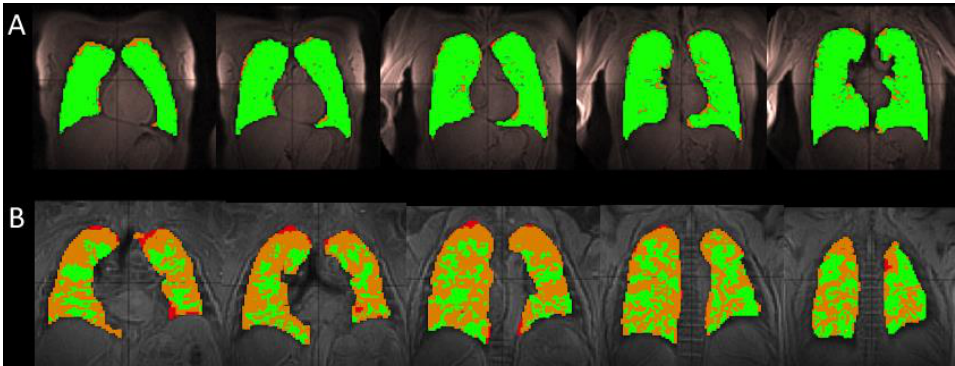
Figure 1. A comparison of the segmented ventilation images for a single healthy (H2) ( A ) and IPF (I2) subject ( B ). The healthy subject has mainly areas of normal (green) ventilation, with hypoventilation (orange) and no ventilation (red) areas located on the periphery of the lung, occupying 4.8% of the total lung volume for this particular subject. In the IPF subject, these large ventilation defects located on the periphery of the lung encroach toward the center of the lung, occupying 35.1% of the total lung volume. The IPF subject retained a portion of the inhaled xenon in the trachea and bronchi, resulting in the high intensity of gas in those areas (not shown). The segmentation algorithm excluded these regions to avoid overestimating the volume of the lungs and areas of ventilation.